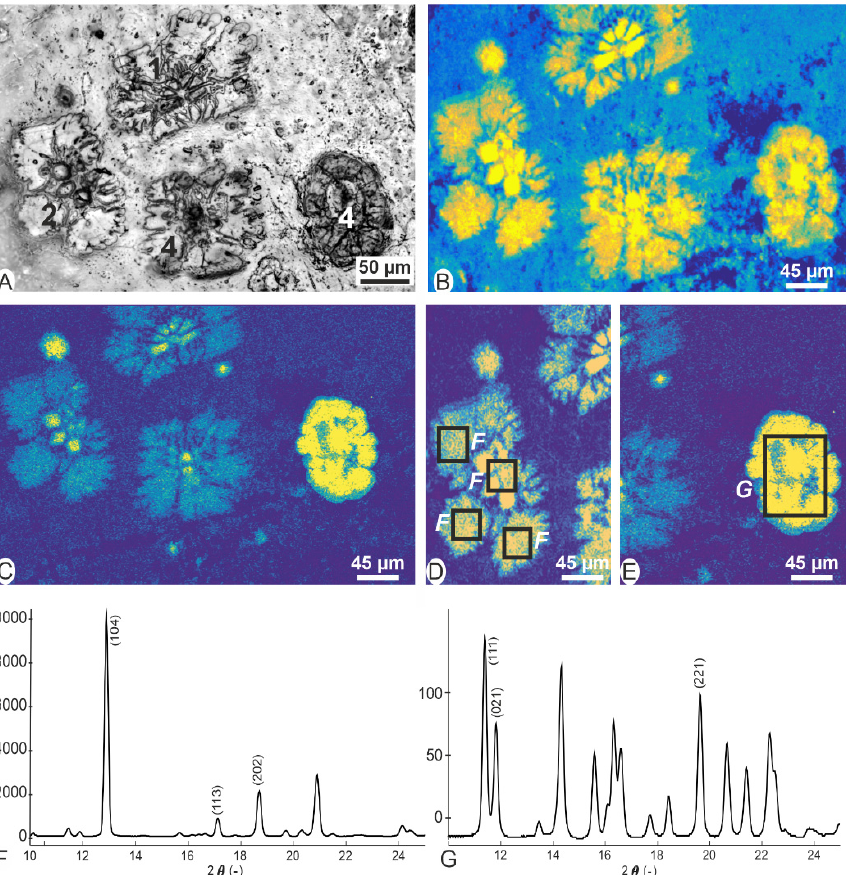
Figure 3. Simultaneous deposition of calcite and aragonite units in the first post-grafting mineralization stage. ( A ) Light microscope view (natural light) of four mineralized units. ( B ) Calcium fluorescence. ( C ) High strontium fluorescence in unit 4; low strontium fluorescence in units 1, 2, and 3. ( D , E ) Selected areas from which X-ray diffraction data were collected. ( F , G ) Corresponding X-ray diffraction diagrams. In both cases, typical diagrams for calcite ( F ) and aragonite ( G ) are obtained suggesting remarkable consistency in the orientation of the mineral particles.